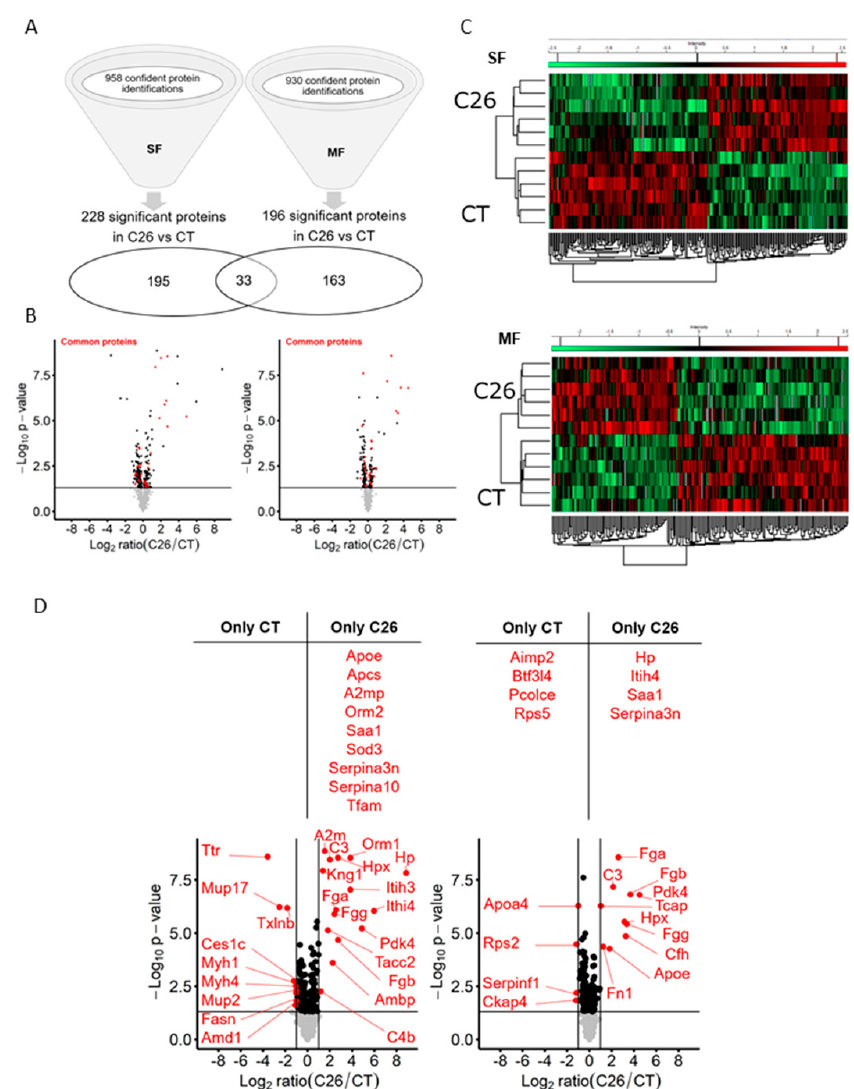
Figure 2. C26 cancer-induced cachexia is associated with profound changes in the skeletal muscle proteome. Global and di ff erential proteomic analyses of gastrocnemius (GC) muscle from male mice injected with C26 cells (C26) or vehicle (CT). ( A ) Total number of confident protein identifications and di ff erentially abundant proteins (DAPs) between C26 and CT muscle ( p < 0.05) in the sarcoplasmic (SF) and the myofibrillar (MF) fractions. Venn diagram shows shared and unique significant DAPs in the two fractions. Full protein lists are shown in Table S1. DAPs found in the di ff erential analysis are communicated in Table S2. ( B ) Volcano plots of the distribution of the 228 and 196 DAPs in the SF and MF, respectively. Red plots represent the 33 common proteins between the two fractions. Y-axis represents -Log10 p -value and x-axis represents Log2 ratio (C26 / CT). The dark line shows the significance threshold limit ( p = 0.05). ( C ) Heatmap of DAPs found in SF and MF in each mouse ( n = 6 / group) showing downregulated proteins in green and upregulated proteins in red. ( D ) Volcano plot of the proteins the most dysregulated (in red) in the skeletal muscle of C26 mice. Top: list of proteins only detected in one group (CT only or C26 only) in the SF and the MF. Bottom: DAPs between C26 and CT muscle with y-axis representing − Log10 p -value (threshold limit line at p = 0.05) and x-axis representing Log2 ratio C26 / CT with vertical lines at + 1 or − 1 Log2 ratio (C26 / CT) corresponding to a ratio C26 / CT = 2 and C26 / CT = 0.5,